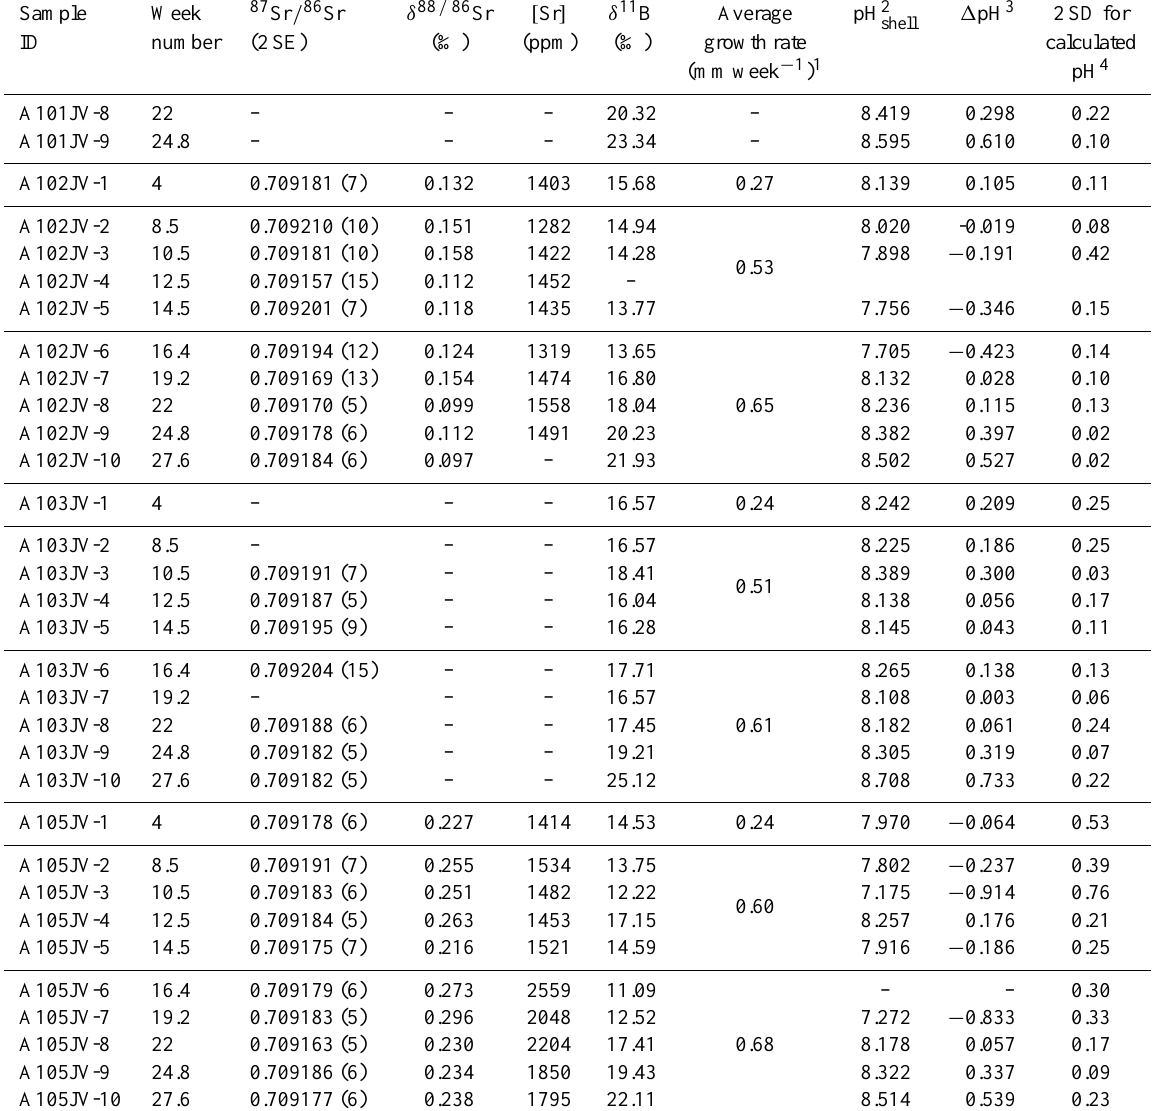
Table 3. Summary of shell data.